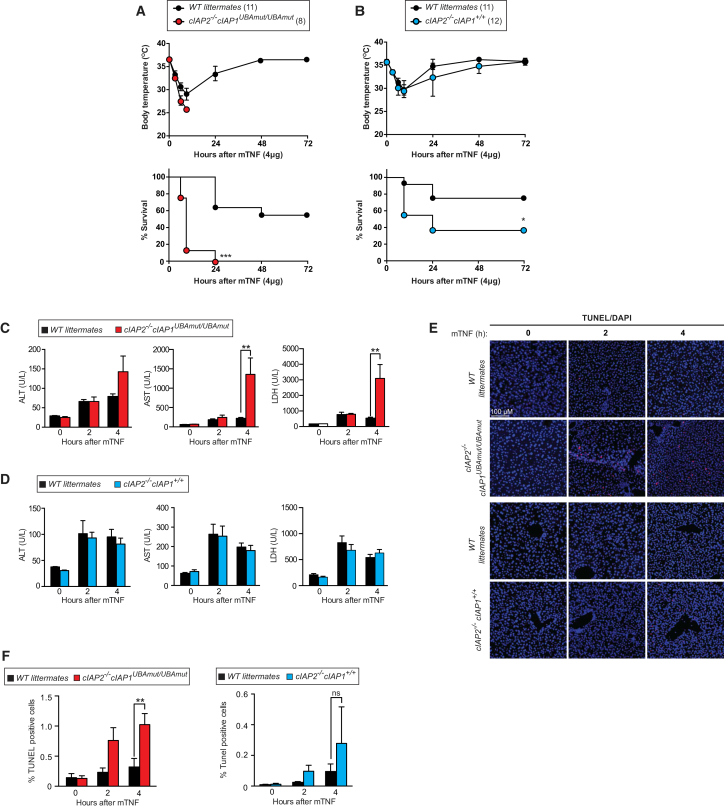
Mice with a Knockin Mutation in the UBA Are Acutely Sensitive to TNF-Induced Systemic Inflammatory Response Syndrome(A and B) Body temperature and survival of WT (A, n = 11; B, n = 12) and corresponding littermate cIAP1UBAmut (A, n = 8) or cIAP2−/− (B, n = 11) mice injected with 4 μg/20 g body weight of mTNF. Data are representative of two independent experiments. Error bars represent SD. Survival curves were compared using log-rank Mantel-Cox test (∗p < 0.05, ∗∗∗p < 0.001).(C and D) Plasma samples of WT and cIAP1UBAmut (C) or cIAP2−/− (D) mice were collected at the indicated time points following challenge with mTNF (4 μg/20 g body weight, intravenously [i.v.]) and analyzed for activities of LDH, AST, and ALT. n = 4 per time point and genotype. Data are presented as mean ± SD, ∗∗p < 0.01; statistics were performed using two-way ANOVA.(E and F) TUNEL staining (E) and quantification (F) of liver sections of WT and cIAP1UBAmut mice used in (C) and (D).Data in (A) and (B) were obtained from two sets of animals, while the data shown in (C)–(F) were obtained from a third set of animals. Graphs show mean ± SD, ∗∗p < 0.01; statistics were performed using two-way ANOVA.